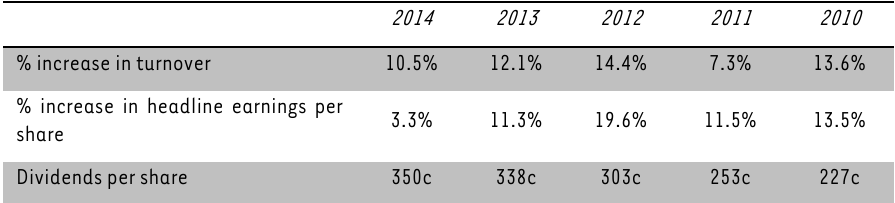
TABLE 13: Shoprite performance statistics from 2010 to